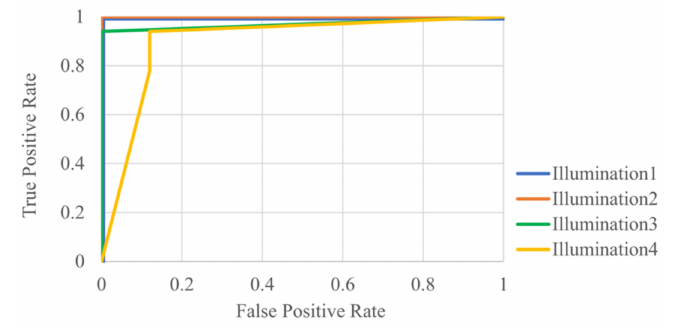
Figure 22. The ROC curve of VggNet under different illuminations.